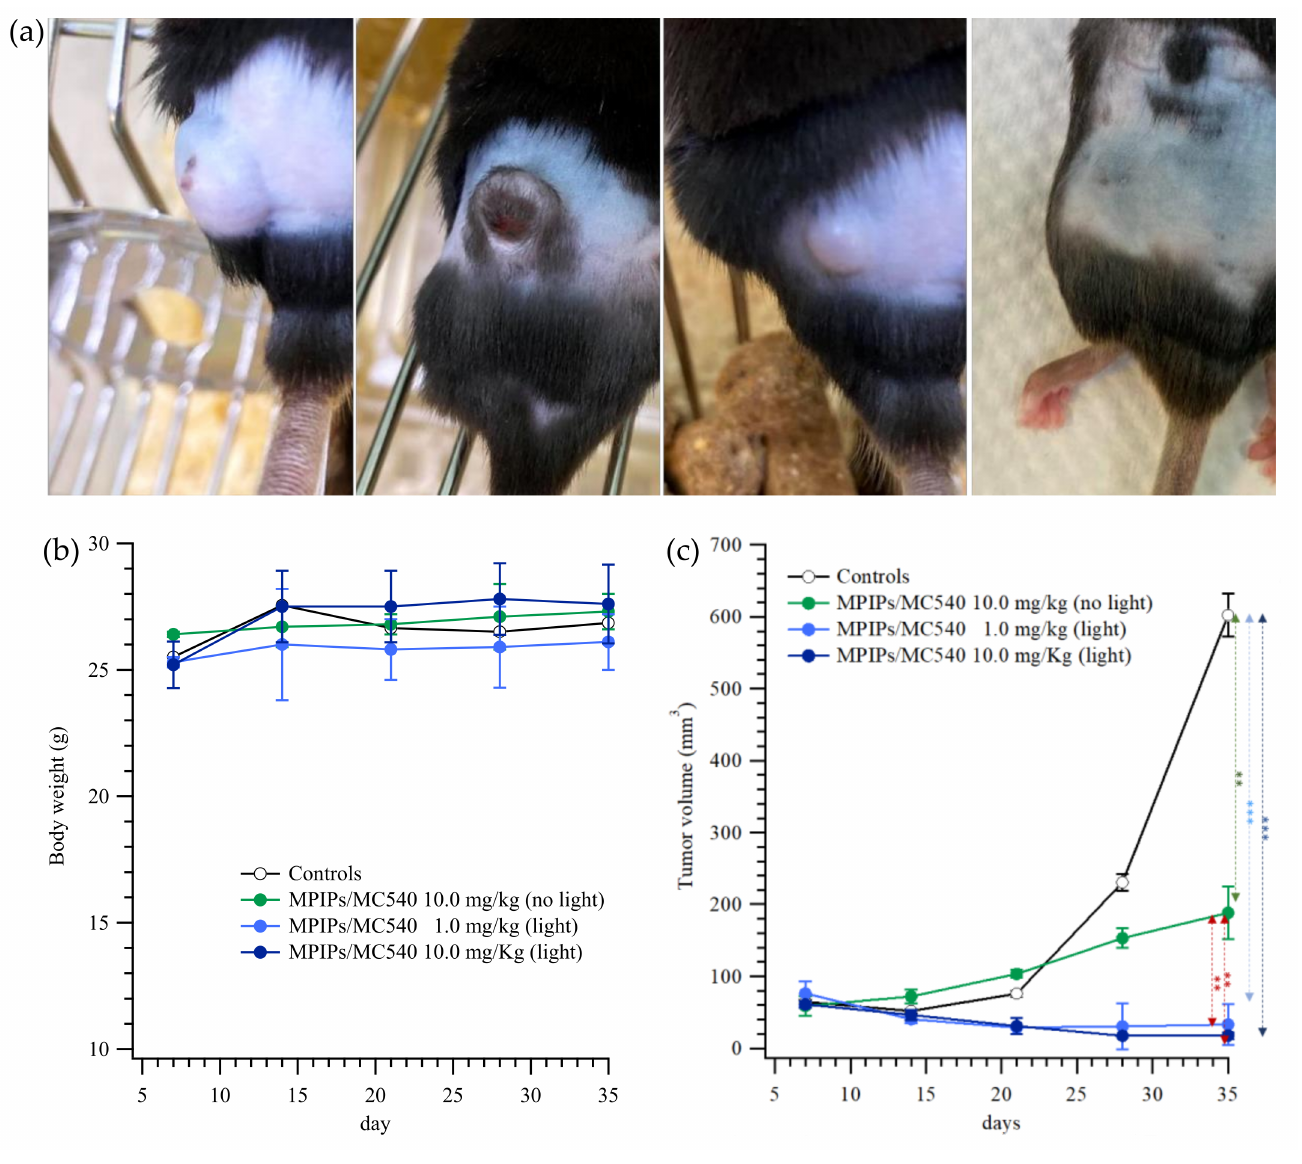
Figure 5. ( a ) Pictures of mice with treatment of PBS, 10.0, 1.0 and 10.0 mg/kg of MPIPs/MC540; the latter two groups were irradiated with 15 min of an LED mini dot light 1 h after injection. ( b ) Body weight of mice during the treatment. ( c ) The tumor size measured on the four groups of mice mentioned in 4 ( a ) (** p < 0.005; *** p <